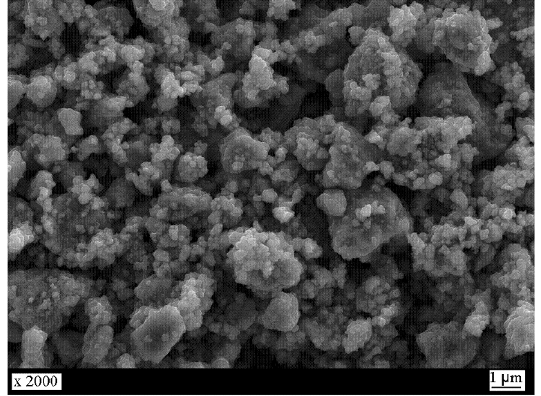
Figure 3. SEM image of ZnO powder mechanically activated at 500 rpm, 1 h milling